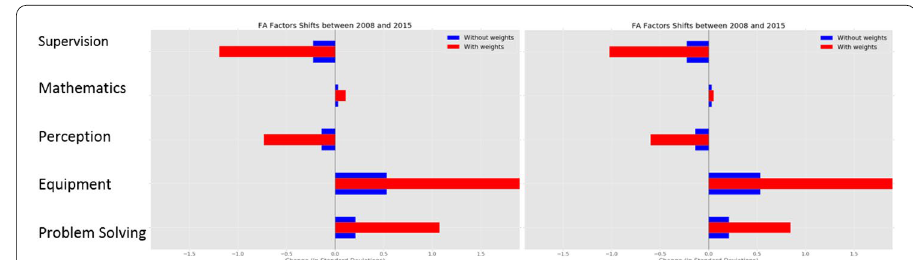
Fig. 14 FA GCC (left) and USA (right) oil & gas